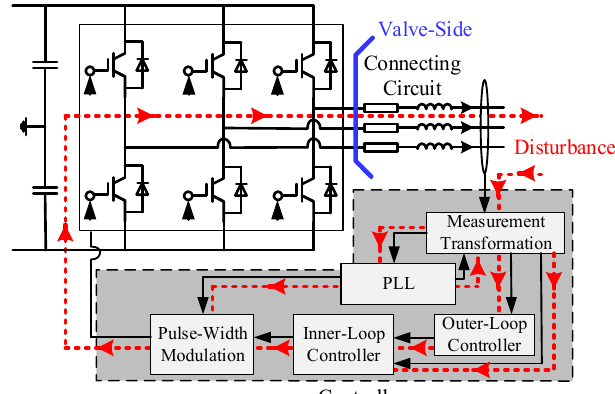
Figure 2. Influencing trajectory of disturbances in grid-side converter.